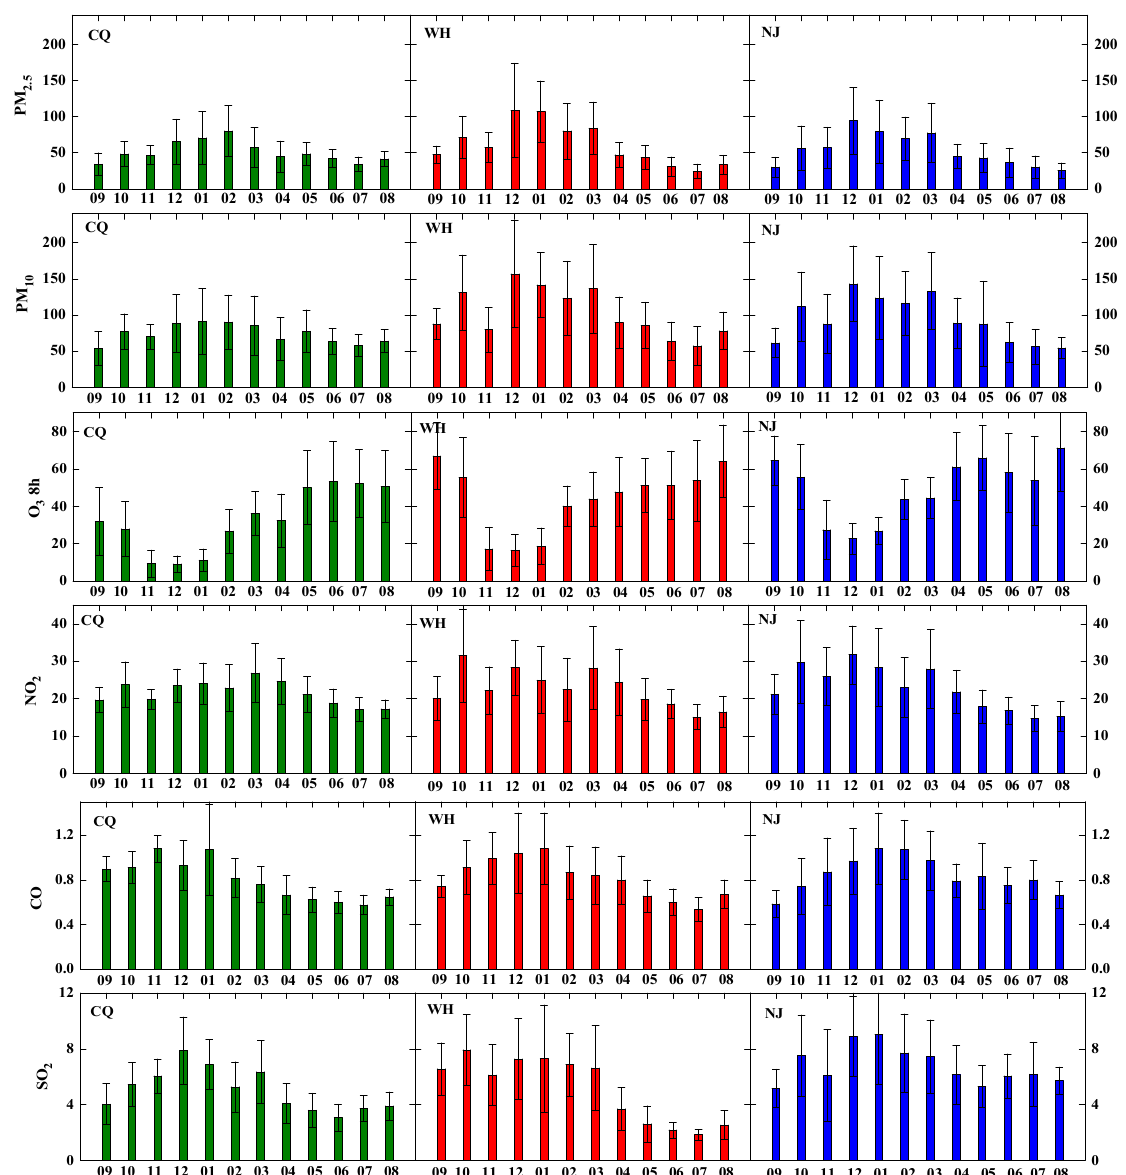
Figure 6. Monthly averaged air pollutants in Chongqing (CQ), Wuhan (WH), and Nanjing (NJ) (The error bar represents standard deviation. Units are μg/mg 3 for PM 2.5 and PM 10 , ppb for O 3 -8h, NO 2 and SO 2 , and ppm for CO).